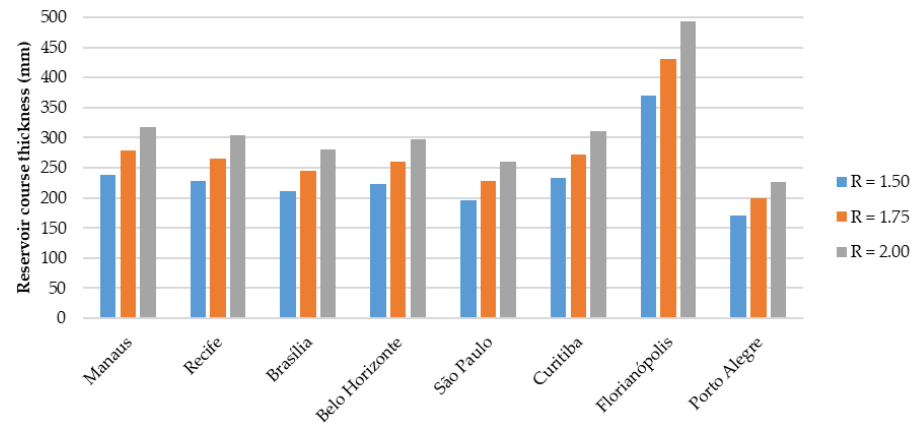
Figure 9. Hydrologic/hydraulic design thickness.